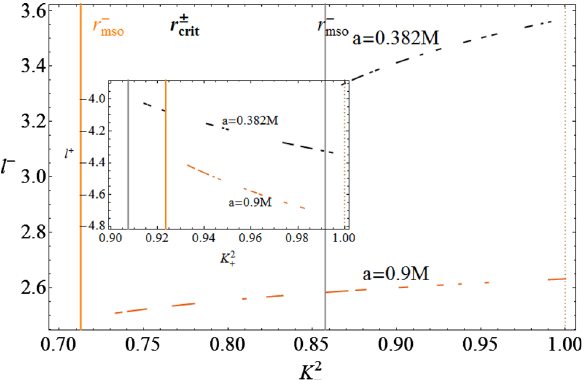
Fig. 10 Fluidangularmomentum (cid:4) versusparameter K 2 forcorotating (cid:4) − and counterotating fluids (cid:4) + (inset plot), orbiting a SMBH with spin a = 0 . 382 M (black line) and a = 0 . 9 M (orange line). Curves of the planes (cid:4) ± − K 2 sets the inner edges of the accreting RAD tori. Note that thisinformationisprovidedbycombining (cid:4) crit and K crit atfixedspinin r ∈] r mbo , r mso ] with (cid:4) crit ∈] (cid:4) mbo ,(cid:4) mso ] and K crit ∈ [ K mso , 1 [ . Radii ( a ) arealsoplotted. r ± mso ( a ) for K ± mso ,and K = 1,correspondentto r ± mbo Regions bounded by these radii define the tori stability properties and their topology – see discussion in Sect.